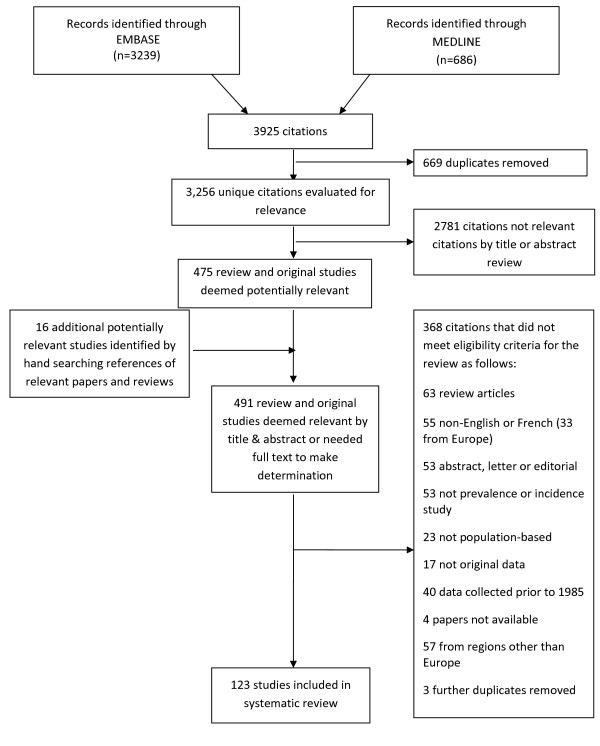
Flow diagram of selection of MS incidence and prevalence studies January 1 1985 – January 31, 2011.